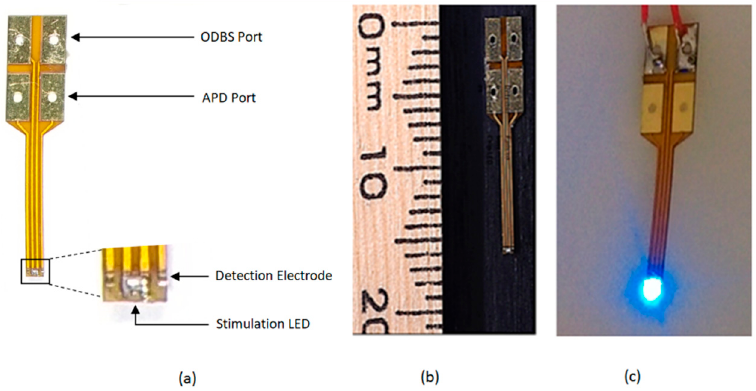
Figure 3. ( a ) Hybrid electrode. ( b ) Electrode size. ( c ) Operation of the LED.